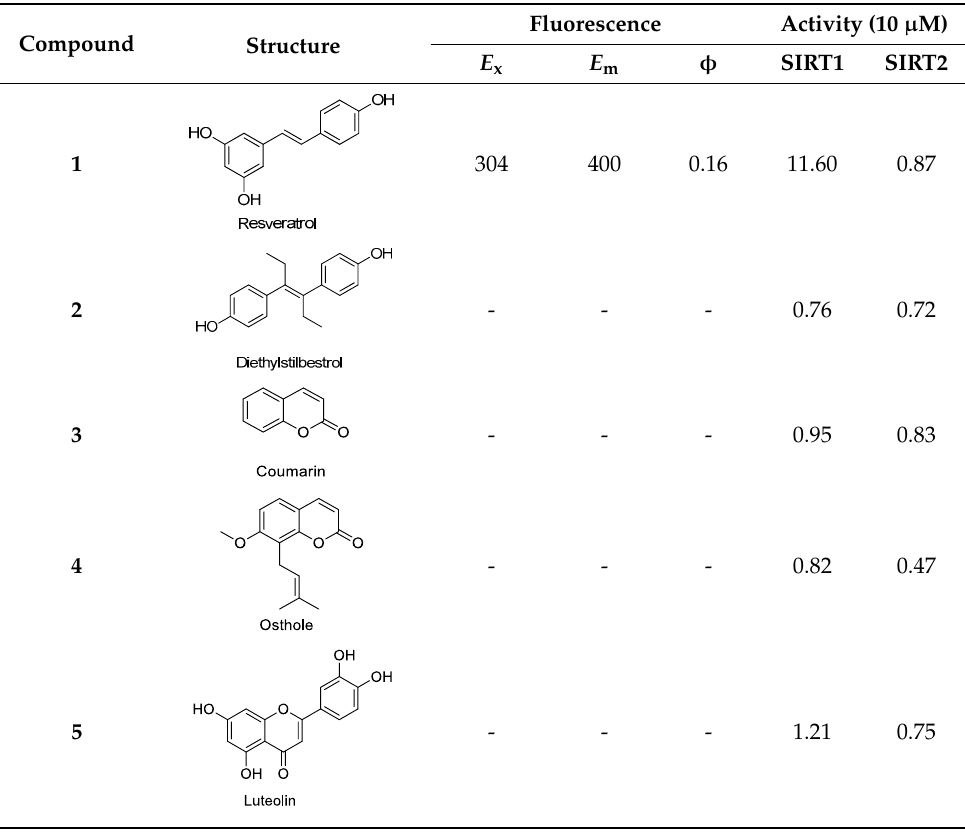
Table 1. The fluorescence properties and SIRT1/2 activities of chromenone compounds. Compound